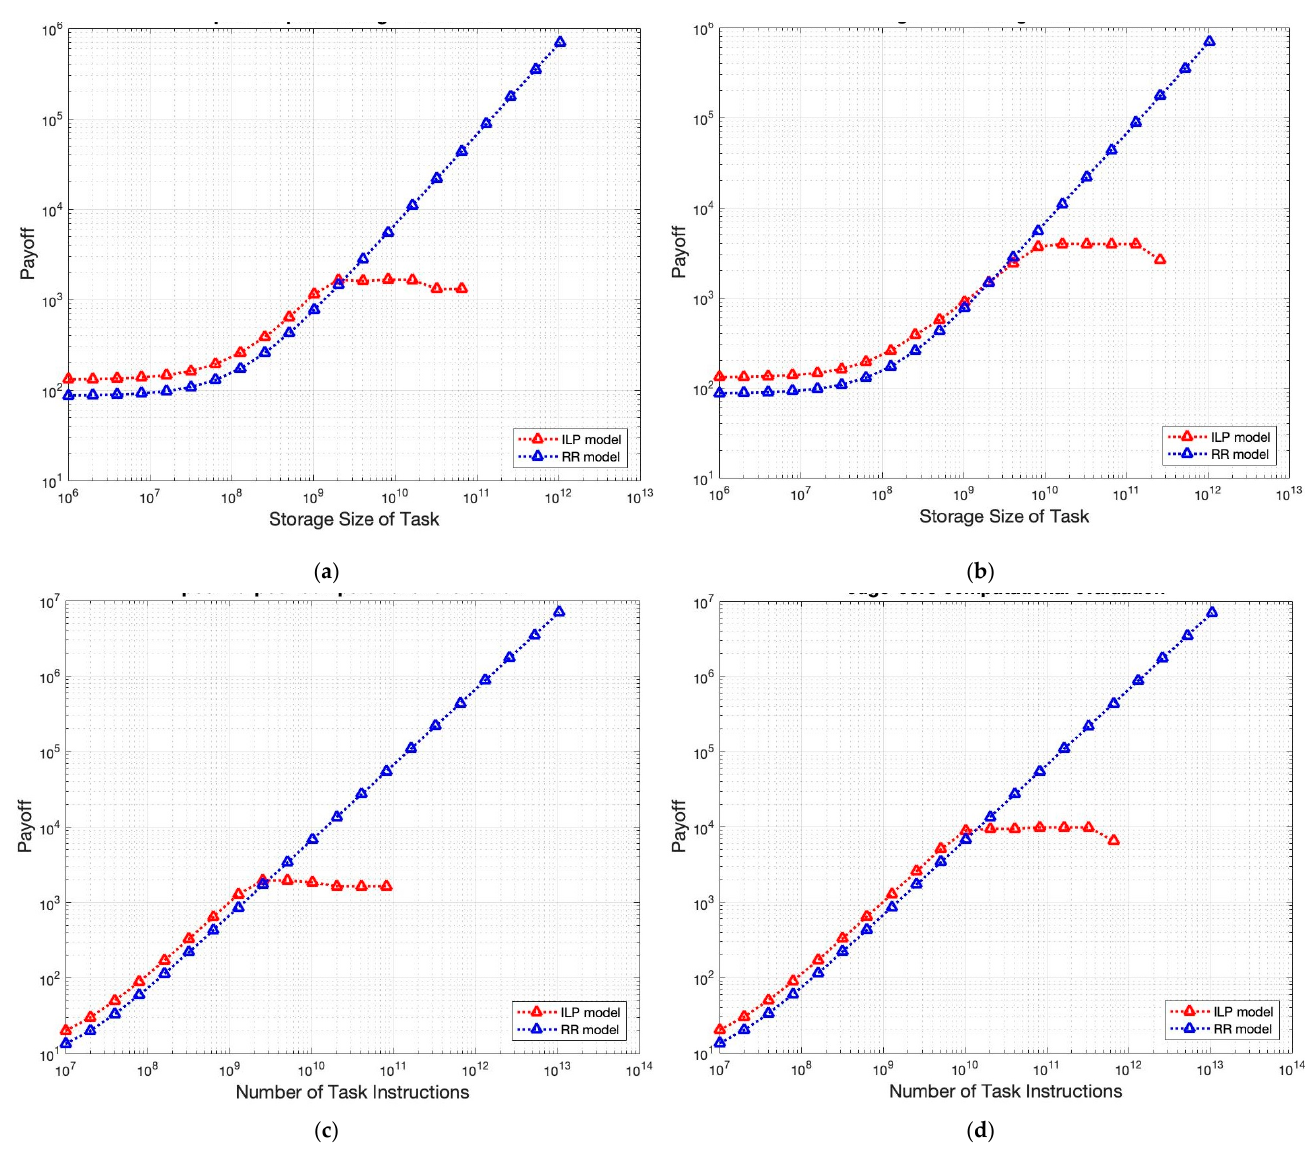
Figure 6. Payoff obtained from cloud computing: ( a ) peer-to-peer federated cluster scenario in case study 1; ( b ) edge-core cluster scenario in case study 1; ( c ) peer-to-peer federated cluster scenario in case study 2; ( d ) edge-core cluster scenario in case study 2.